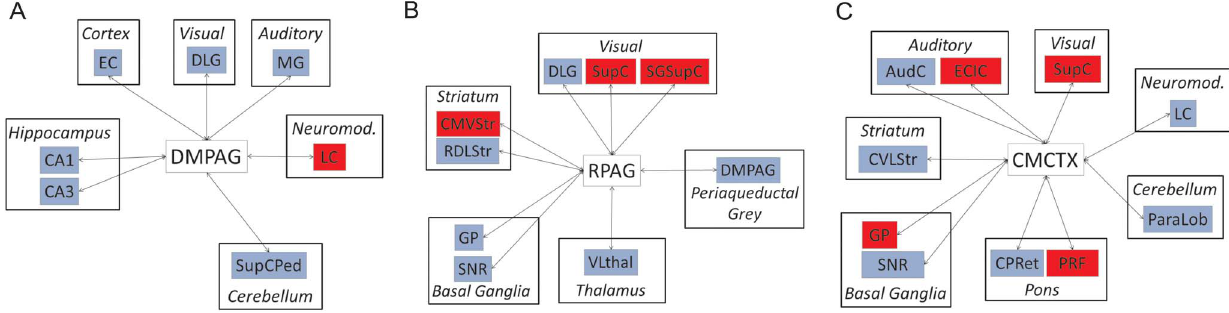
Figure 6. Altered periaqueductal grey and caudal motor cortex functional connectivity in Myk / + mice. Summary diagrams showing altered functional connectivity of (A) dorsomedial (DMPAG) and (B) rostral (RPAG) periaqueductal grey, and (C) caudal motor cortex (CMCTX) in Myk / + mice. Only regions where the 95% CI of the VIP exceeded 0.80, in either Myk / + or + / + mice, were considered to be functionally connected to the defined ‘‘seed’’ region of interest. The I810N Myshkin mutation-induced alterations in functional connectivity were analysed by permutation test (1000 random permutations of the real data) with significance set at P , 0.05. Red denotes a significant increase, whereas blue denotes a significant decrease, in regional functional connectivity in Myk / + mice relative to + / + .